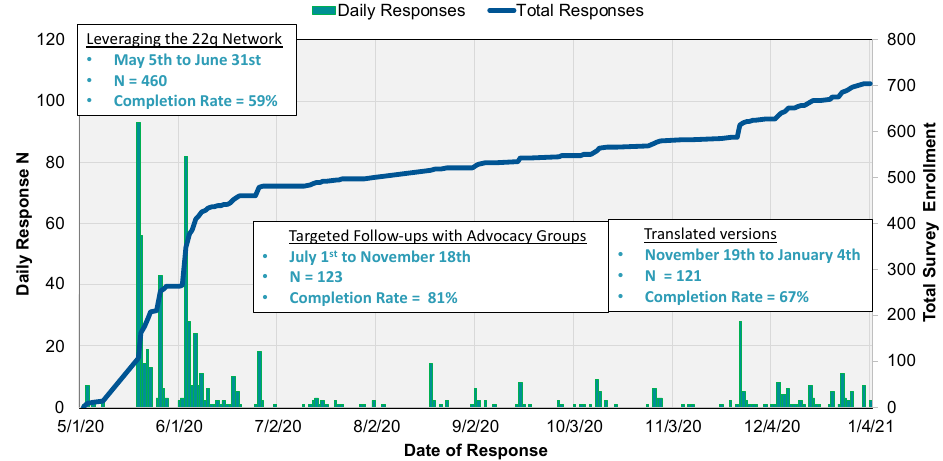
Figure 1. Study Enrollment Over Time.